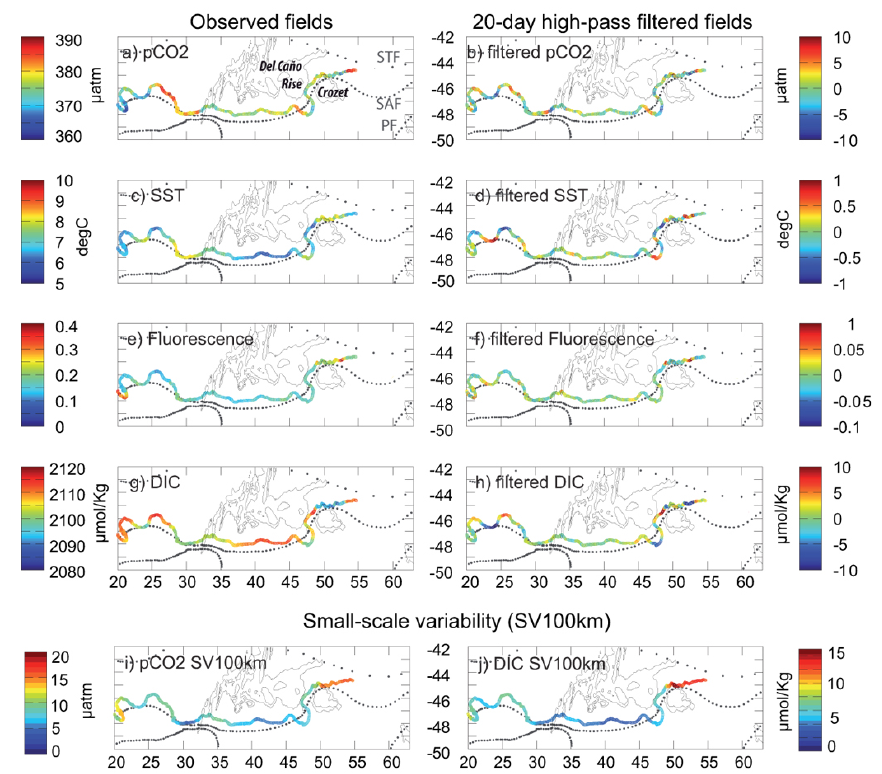
Fig. 2. Case study: drifter 13060 in the Crozet Plateau area. (a, c, e, g) surface p CO 2 , SST, fluorescence and DIC; (b, d, f, h) 20-day high-pass filtered surface p CO 2 , SST, fluorescence and DIC; (i–j) SV100km quantifying small-scale spatial variability of p CO 2 and